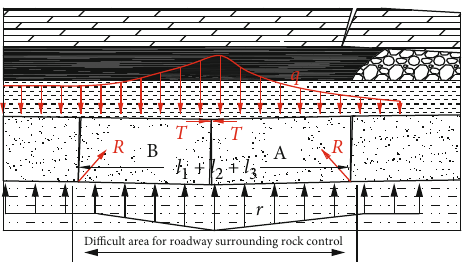
Figure 9: Mechanical action of fracture